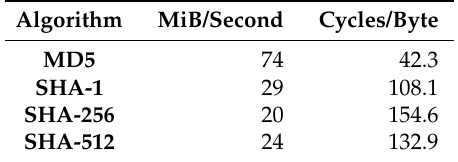
Table 1. Crypto++ self-assessment of its hash functions’ performance.